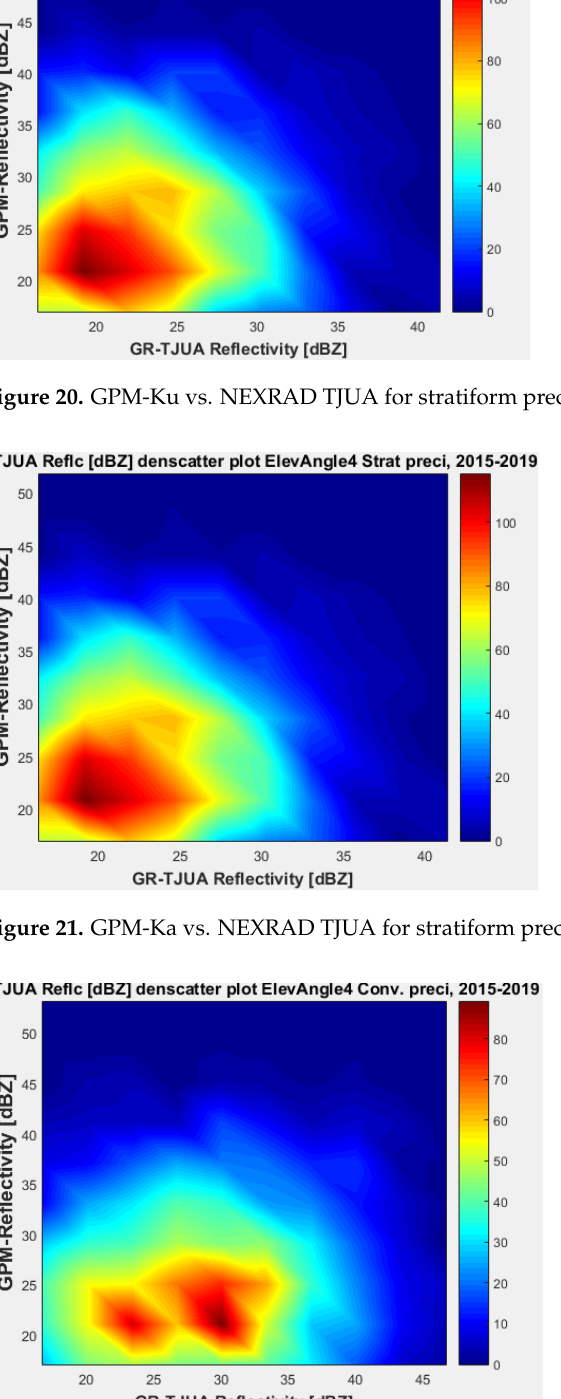
Figure 22. GPM ‐ Ku vs. NEXRAD TJUA for convective precipitation (angle 4).